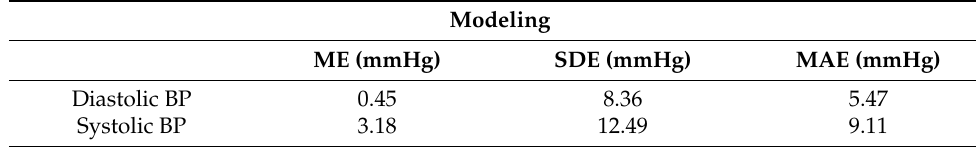
Table 4. Blood pressure estimation performance using reflective PTT in a calibrated mathematical model with 30 PPG waveforms. The results are averaged over the 30 patients.